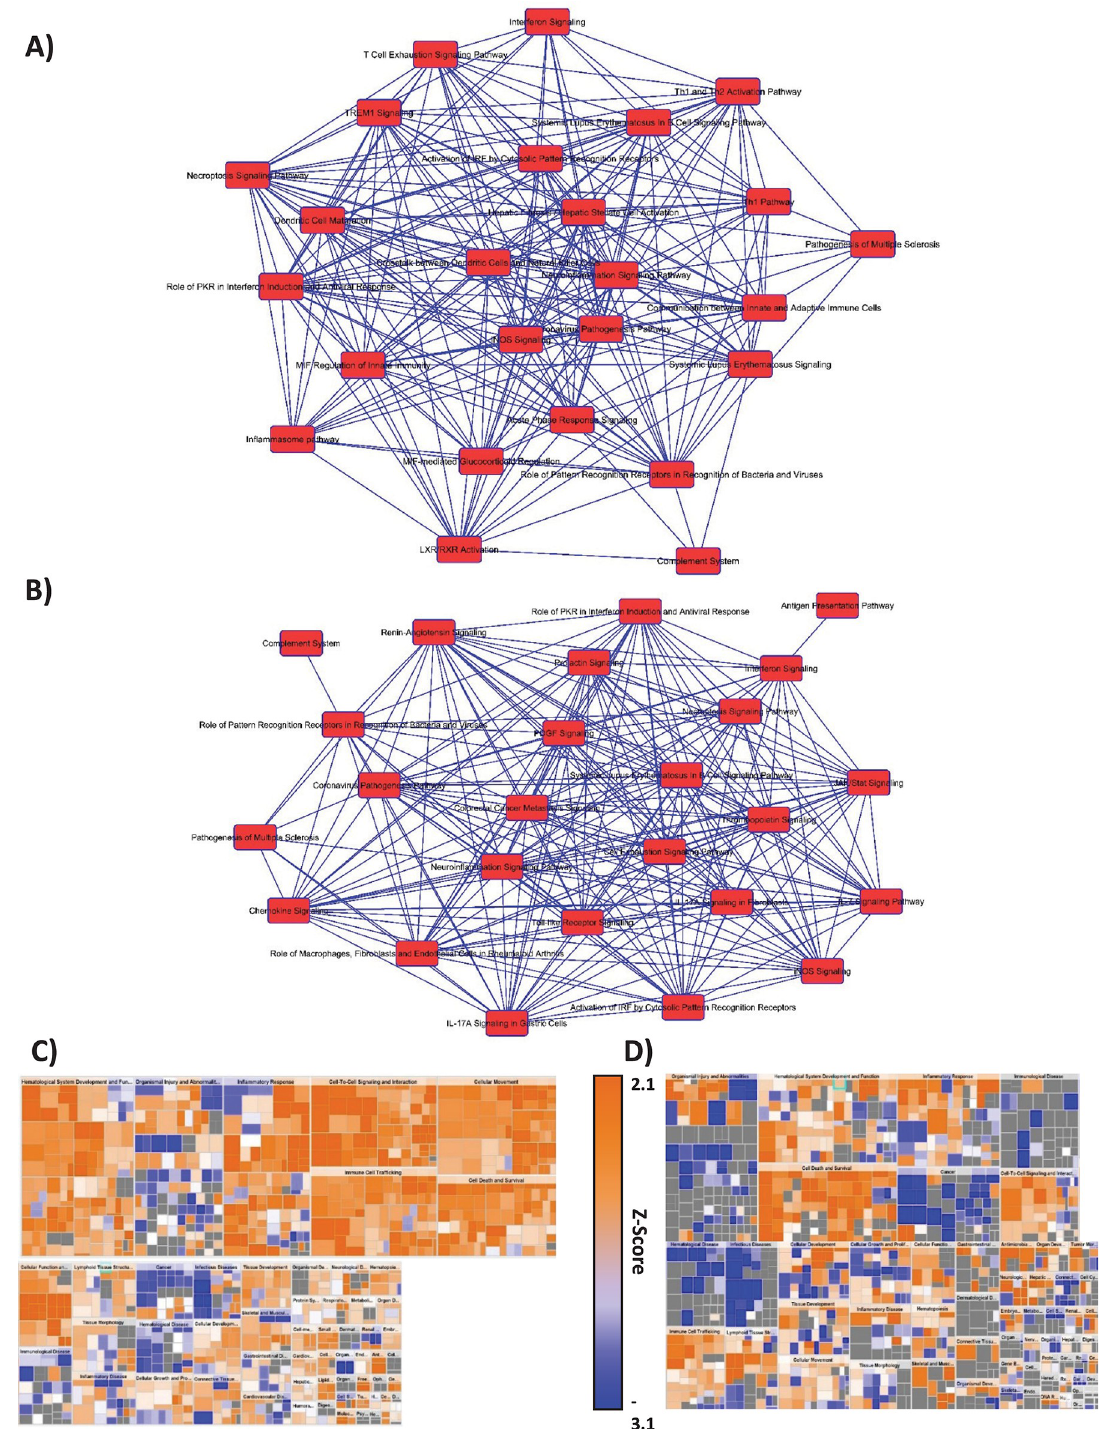
Fig 3. Ingenuity Pathway Analysis of Differentially Expression Genes in ANDV and HTNV Infected Hamsters. Pathway analysis was completed using gene expression data collected from ANDV and HTNV infected hamsters at 10 dpi. Overlap graphs showing relationship between the 25 most significantly enriched pathways in A) ANDV and B) HTNV infected hamsters. Blue lines indicate at